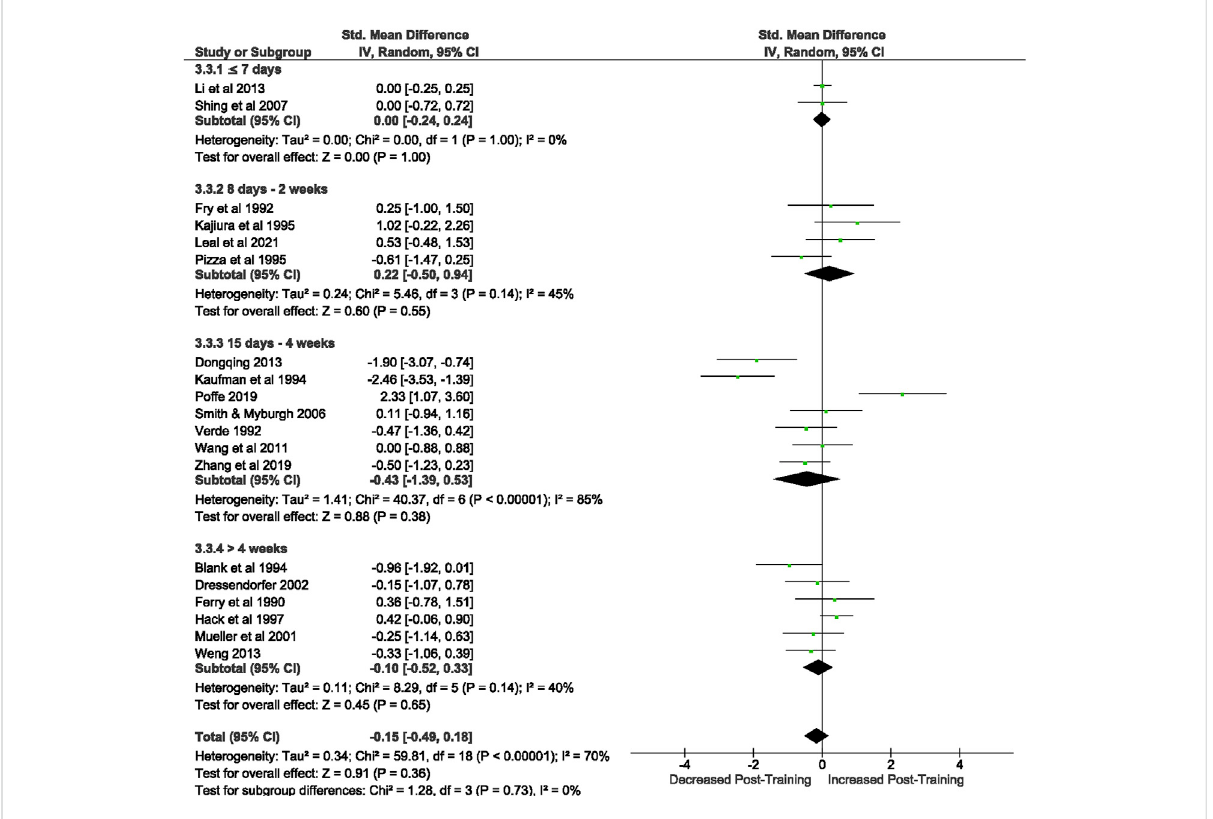
FIGURE 7 Effect of intensi fi ed training on resting Natural Killer cells, measured by FACS or Automated cell counter. Subgroup analysis is based on the duration of intensi fi ed training period; ≤ 7 days, 8 days — 2 weeks, 15 days — 4 weeks and > 4 weeks. All studies used human participants. CI Con fi dence